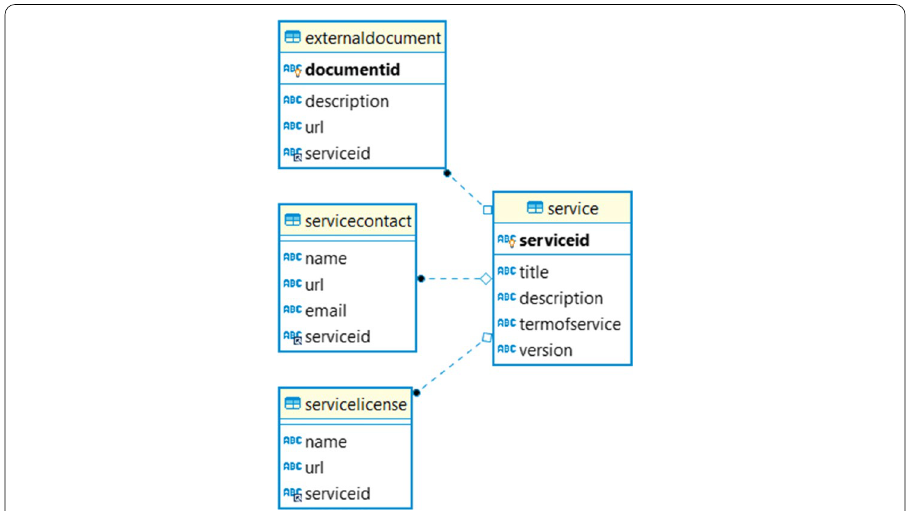
Fig. 5 Relational tables mapped to vocabulary